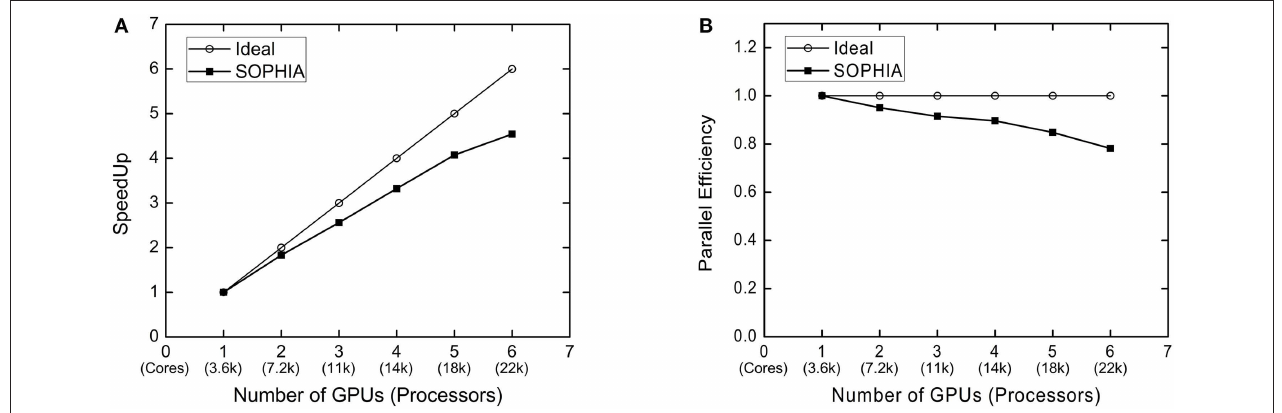
FIGURE 7 | Performance scalability test of multi-GPU code. (A) Speedup factor of strong scaling and (B) efficiency of weak